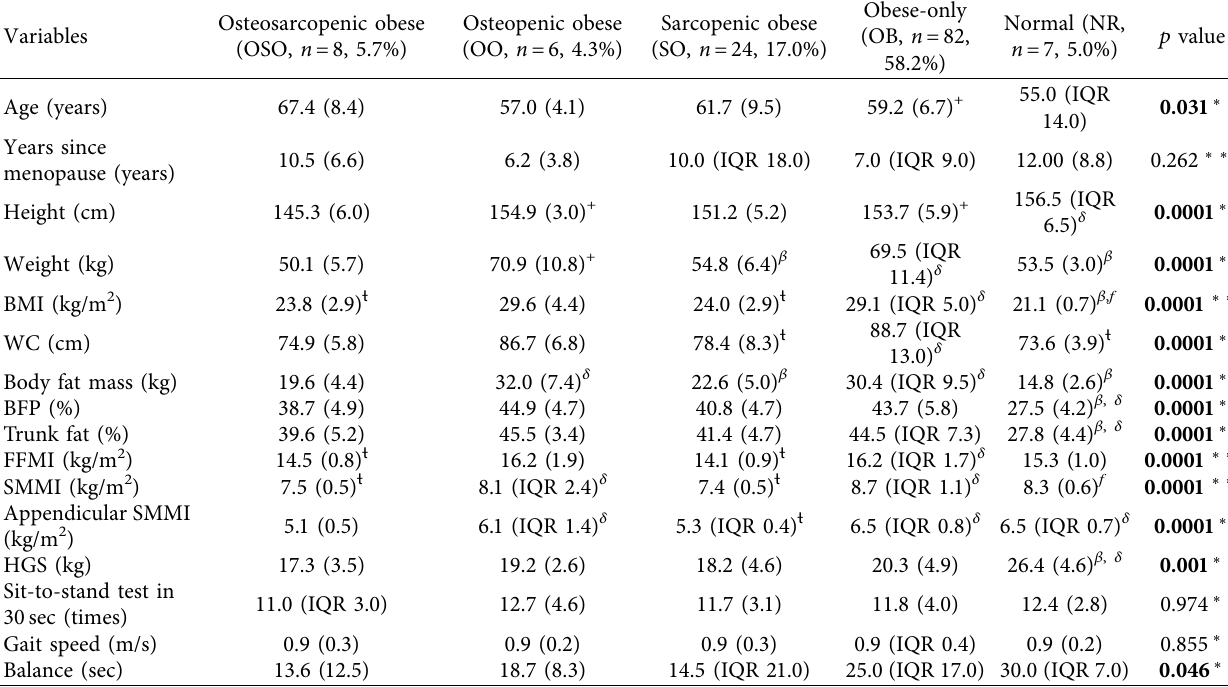
Table 1: Characteristic differences between OSO, OO, SO, OB, and NR participants ( n � 141). Osteosarcopenic obese Variables (OSO, n � 8,